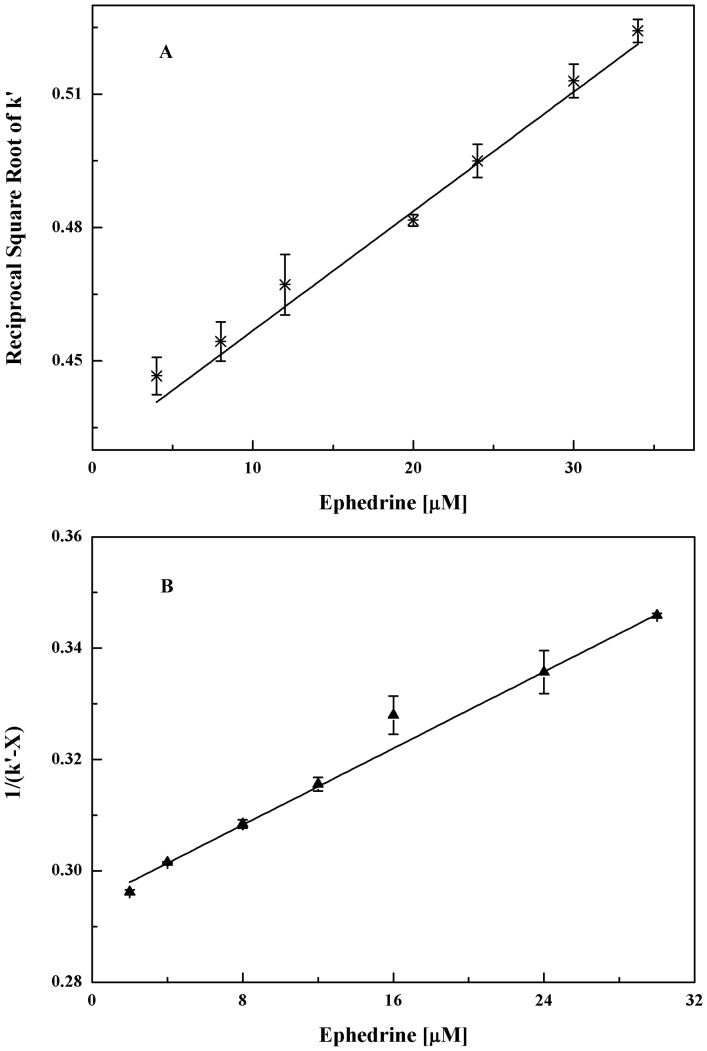
Change in  of ephedrine and 1/(k′-X) of pseudoephedrine with mobile-phase concentrations of ephedrine.Data were from an oriented immobilised β
2-AR column at 37 °C. The equations of the best fit lines were y = (2.58±0.02)×103x+(0.43±0.01) for ephedrine with a coefficient of 0.9962 and y = (1.76±0.07)×103x+(0.29±0.01) for pseudoephedrine with a coefficient of 0.9915. The value of X used for the plot of pseudoephedrine was set at (2.49±0.26). A, Ephedrine at different concentrations was added in the mobile phase. The injection solute was 5.0 nmol of ephedrine; B, Ephedrine at different concentrations was added in the mobile phase while 5.0 nmol of pseudoephedrine was injected as analytes.